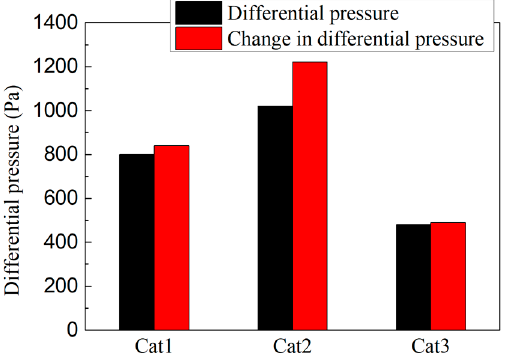
Figure 11. Change in differential pressure after 6 h.